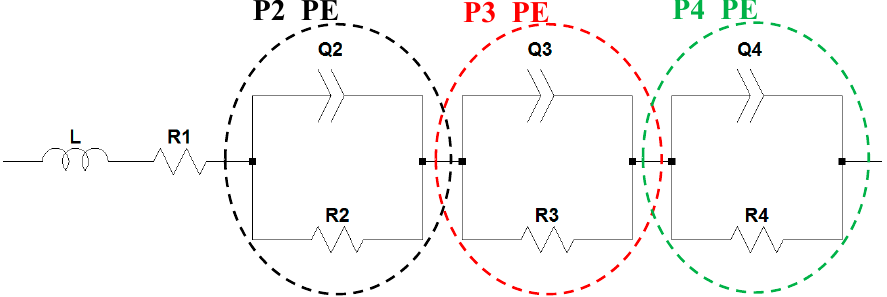
Figure 5. Electrical model employed for fitting the impedance spectra of the PE (positive electrode) half-cell (LCO-NMC/Li).